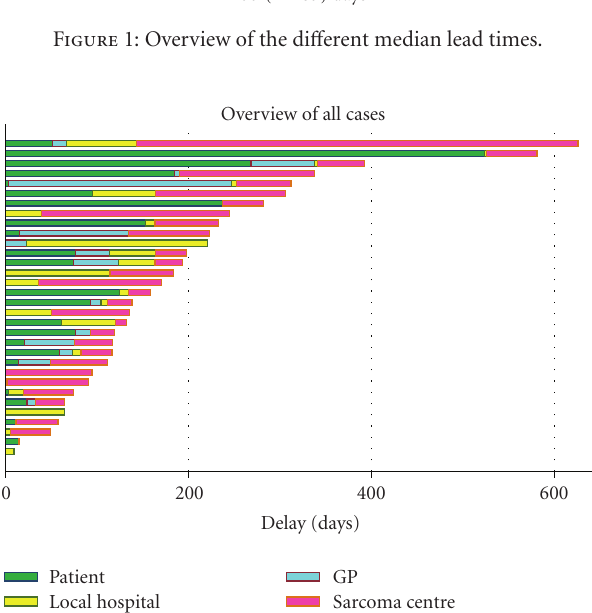
Figure 2: Bar chart demonstrating individual patients’ lead times (one outlier with a 3-year local hospital delay was omitted for reasons of